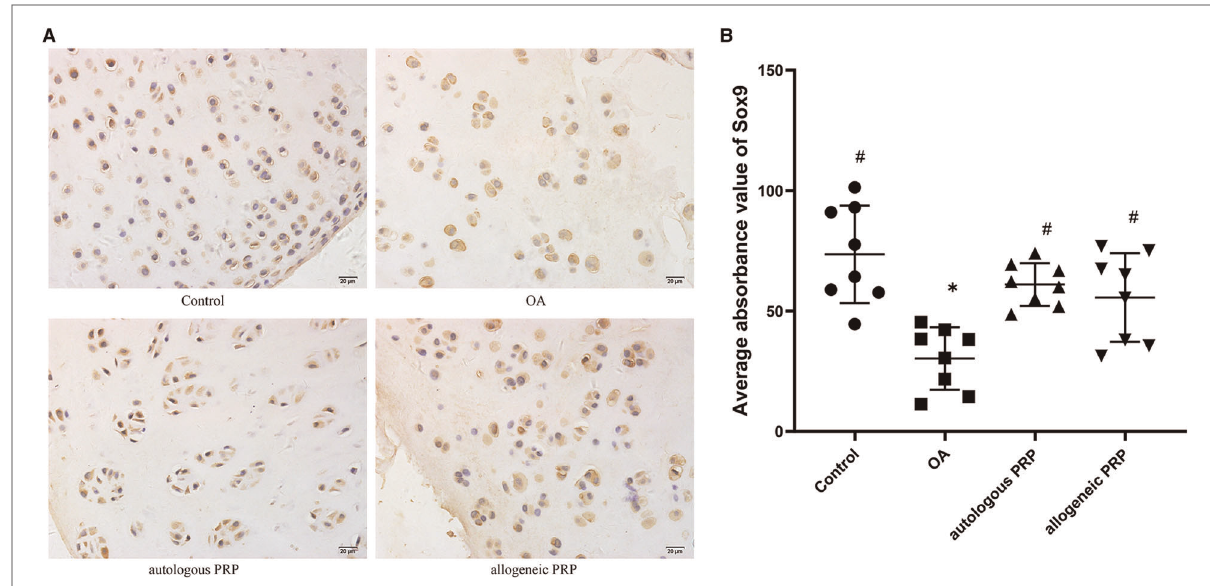
FIGURE 3 ( AB ) Immunohistochemical analysis of SOX-9 in joint fl uid. Scale bar 20 µm. All groups ( n =8). Signi fi cant differences, if any, were indicated as * p <0.05 compared control, # p <0.05 compared to OA, and ? P <0.05 compared to autologous PRP. OA, osteoarthritis; PRP, platelet-rich